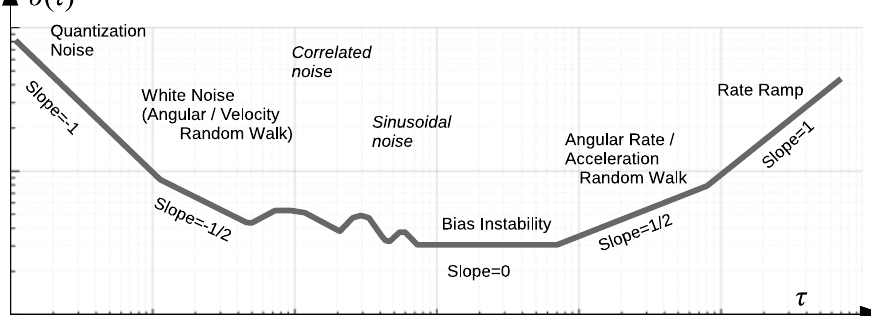
Figure 3. Schematic overview of Allan deviation plot